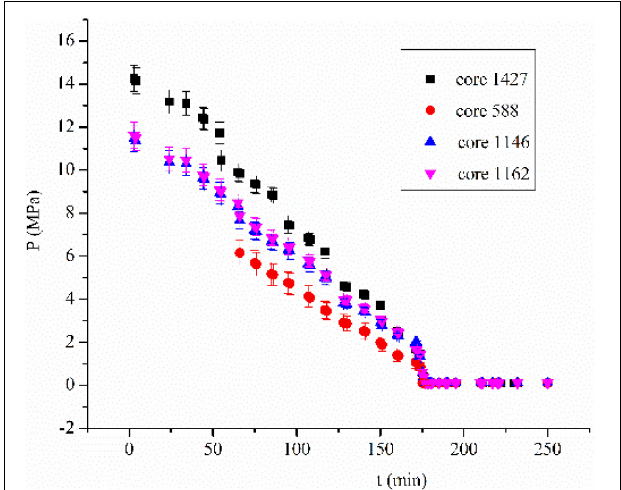
FIGURE 8 | Relationship between the gas injection amount of core and equilibrium pressure. FIGURE 9 | The curve of pressure with time when measuring loss of